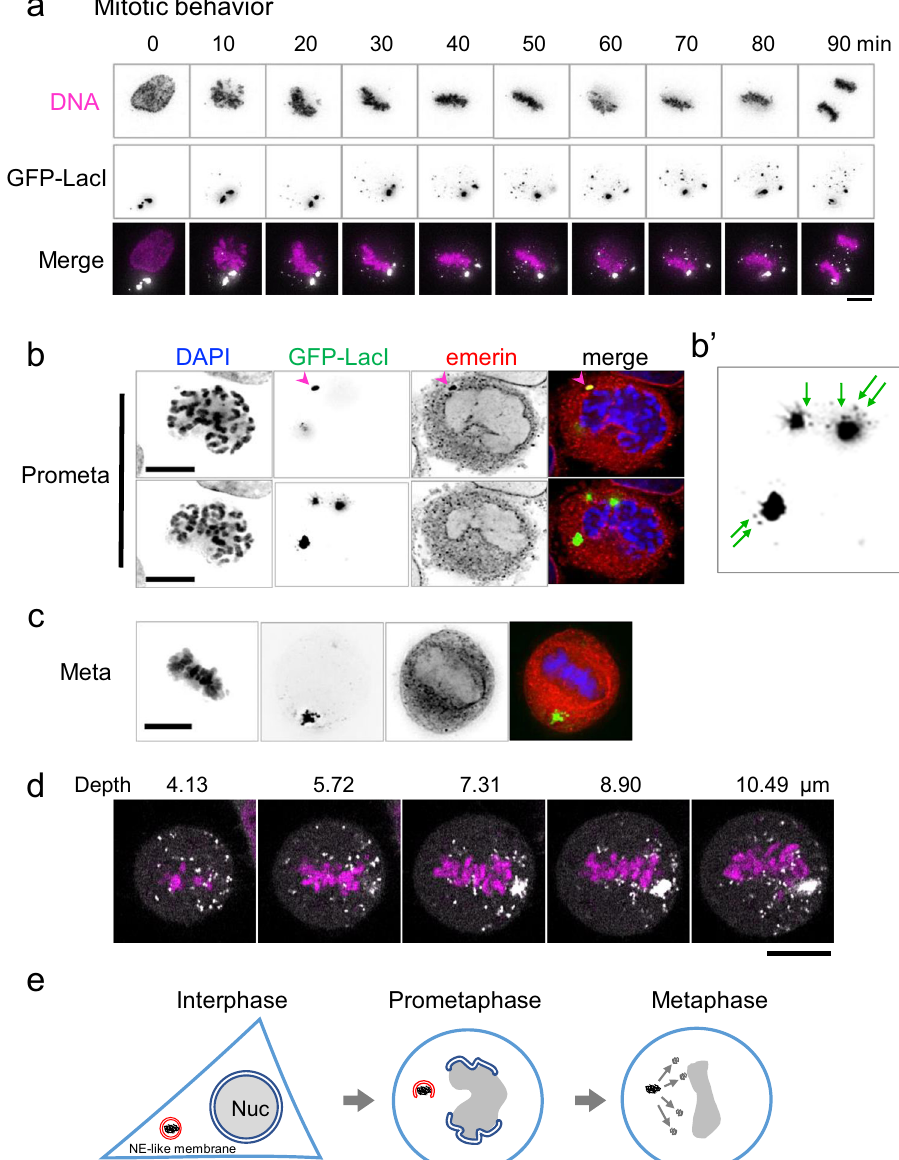
Fig. 2 DNA puncta disperse during mitosis. a Representative time-lapse images of HeLa/GFP-LacI cells transfected with pLacO-pEF1 α -RFP. DNA was stained with Hoechst 33342. Immediately after transfection, acquisition of time-lapse images at 10-min intervals was started. Time 0 represents the leftmost image (680 min after the start of image acquisition). DNA (magenta) and GFP-LacI (white) in the merged images. Bar, 10 μ m. b HeLa/GFP-LacI cells transfected with pLacO-pEF1 α -RFP, fi xed, and stained for emerin as indicated in Fig. 1b. A single, representative prometaphase cell is shown. The upper and lower rows show the same cell at focal planes 1.5 μ m apart. Arrowhead indicate puncta with emerin signals. DAPI (DNA, blue), GFP-LacI (green), and emerin (red) are shown in the merged image. Bars, 10 μ m. b ′ Enlarged image of the lower panel of GFP-LacI in Fig. 2b. Arrows indicate small puncta. c A metaphase cell is shown in the same manner as in b . Bar, 10 μ m. d Super-resolution images of GFP-LacI and chromosomes in a metaphase cell. HeLa/GFP- LacI cells were transfected with pLacO-pEF1 α -RFP. After transfection, cells were fi xed with a fi xative as described in Methods. Super-resolution images were obtained using LSM880 Airyscan microscopy. White and magenta represent small puncta of transfected DNA (GFP-LacI) and chromosomes (DAPI), respectively. Bar, 10 μ m. e Diagrams of transfected DNA in interphase, prometaphase, and metaphase